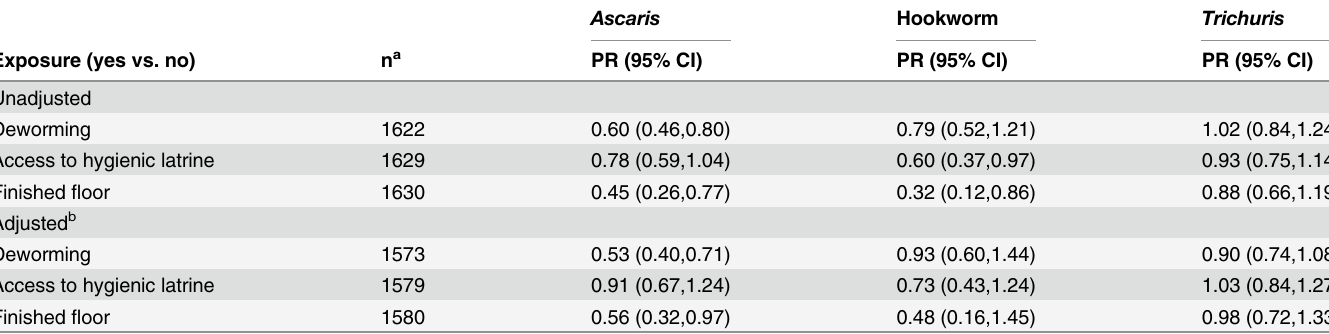
Table 2. Prevalence ratios for deworming, hygienic latrine access, and finished floors.